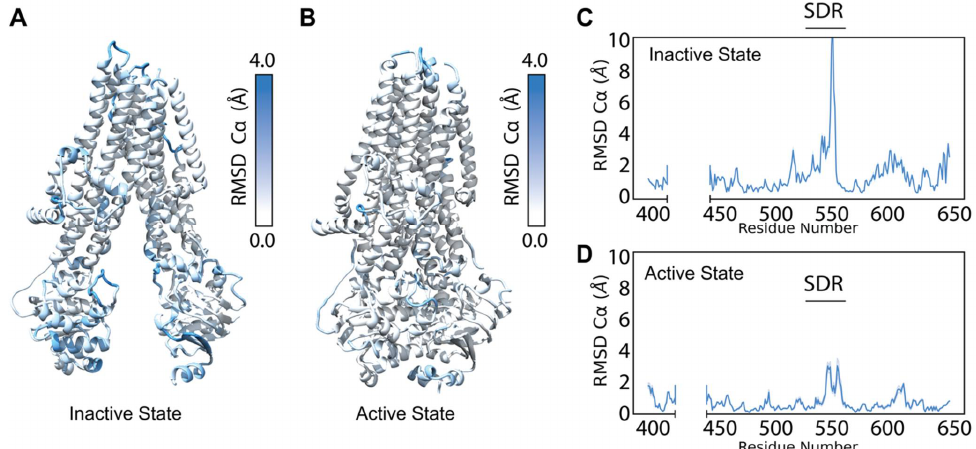
Figure 2. Refinement into the cryo-EM density generates a diverse ensemble of structures. ( A ) Average C α RMSD of the best scoring (lowest 10% by potential energy function) 5UAK cryo-EM refinement models mapped onto 5UAK. ( B ) Average C α RMSD of the best scoring (lowest 10% by potential energy function 6MSM cryo-EM refinement models mapped onto 6MSM. ( C ) The average NBD1 C α RMSD of the best scoring 100 5UAK refinement models. The blue shading represents a 95% confidence interval, and the large C α RMSD demonstrates high structural diversity in the SDR (residues 526–547). ( D ) The average NBD1 RMSD of the best scoring 100 6MSM refinement models. The blue shading represents a 95% confidence